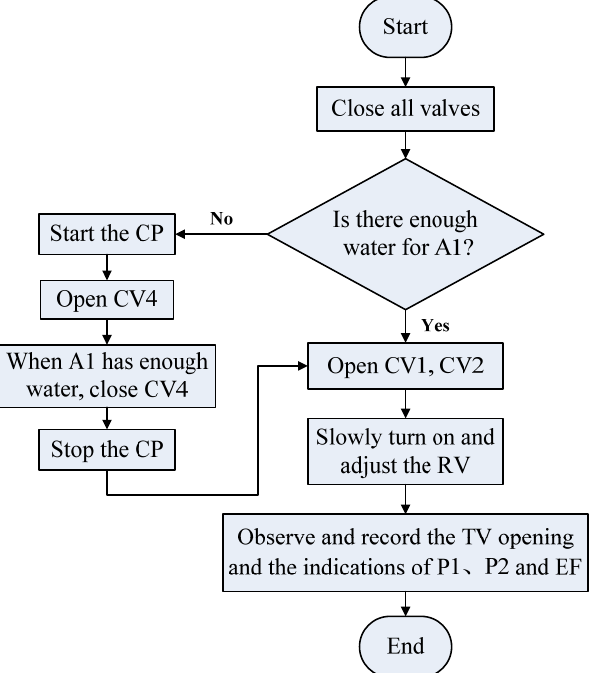
Figure 8. Test flowchart of the resistance characteristics of the dual disc check valve in the opening